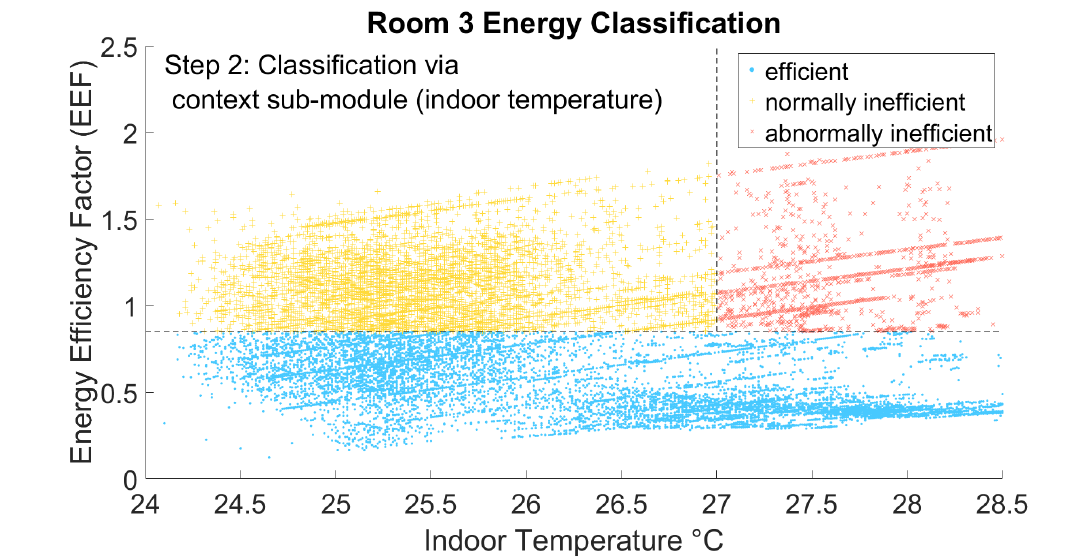
Figure 8. Classification of normal and abnormal behavior based on inference rules in the context sub-module for